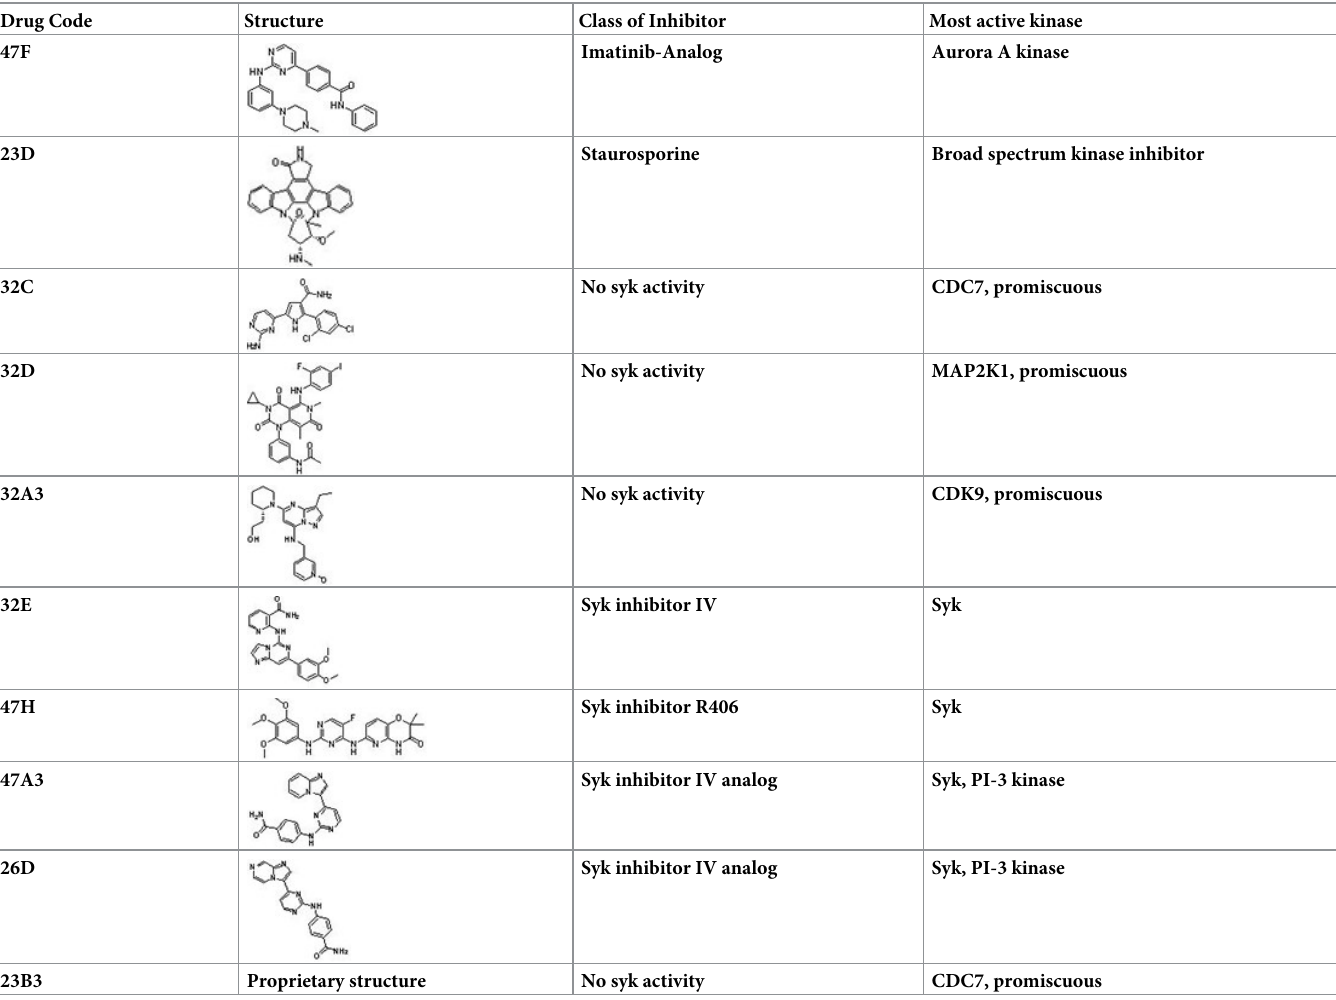
Table 1. Structures of tyrosine kinase inhibitors used in this